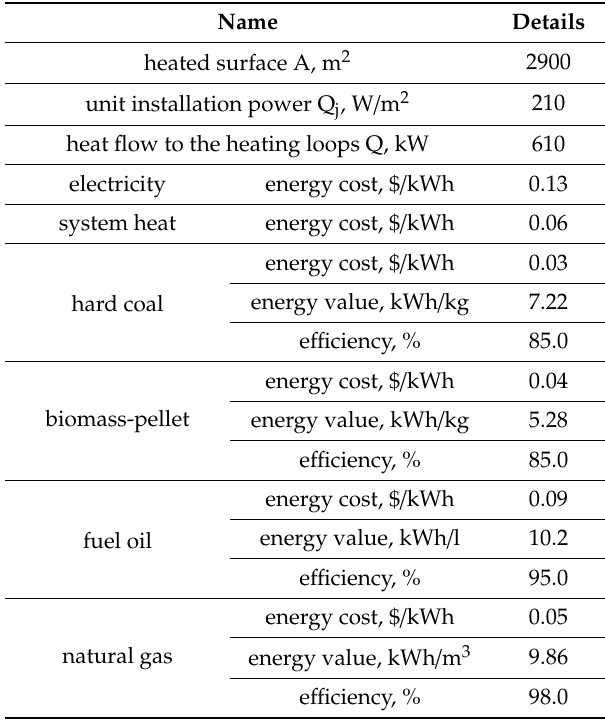
Table 1. Preliminary